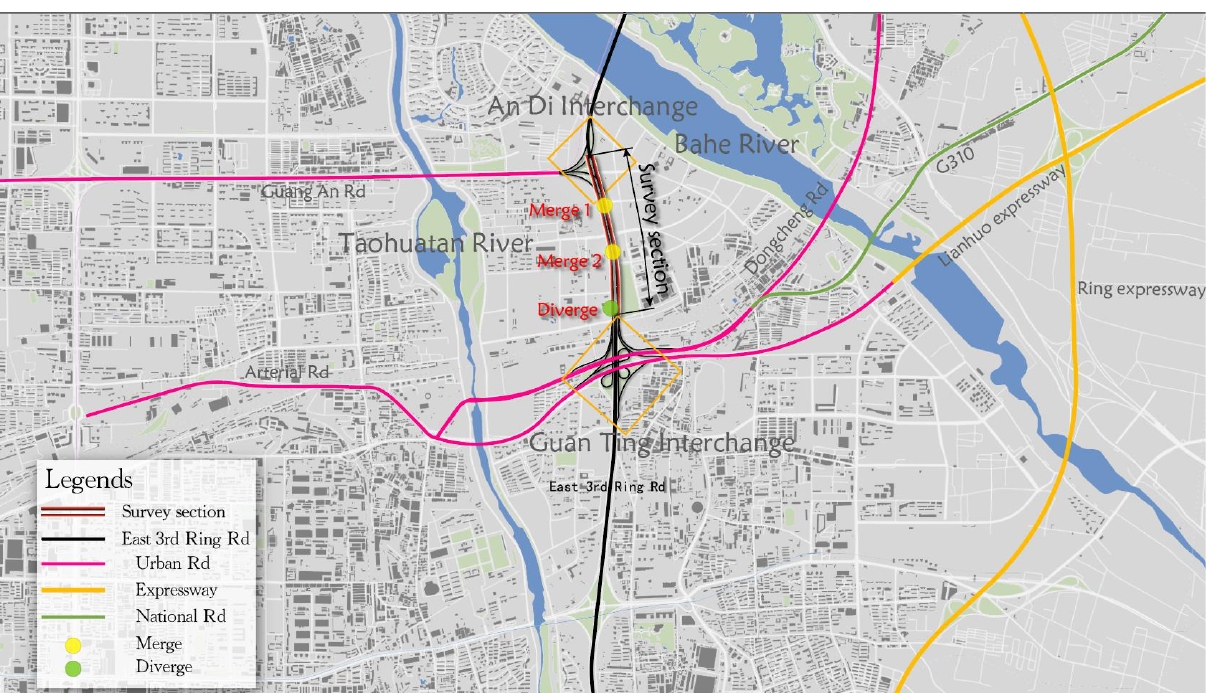
Figure 8. Survey road satellite map.